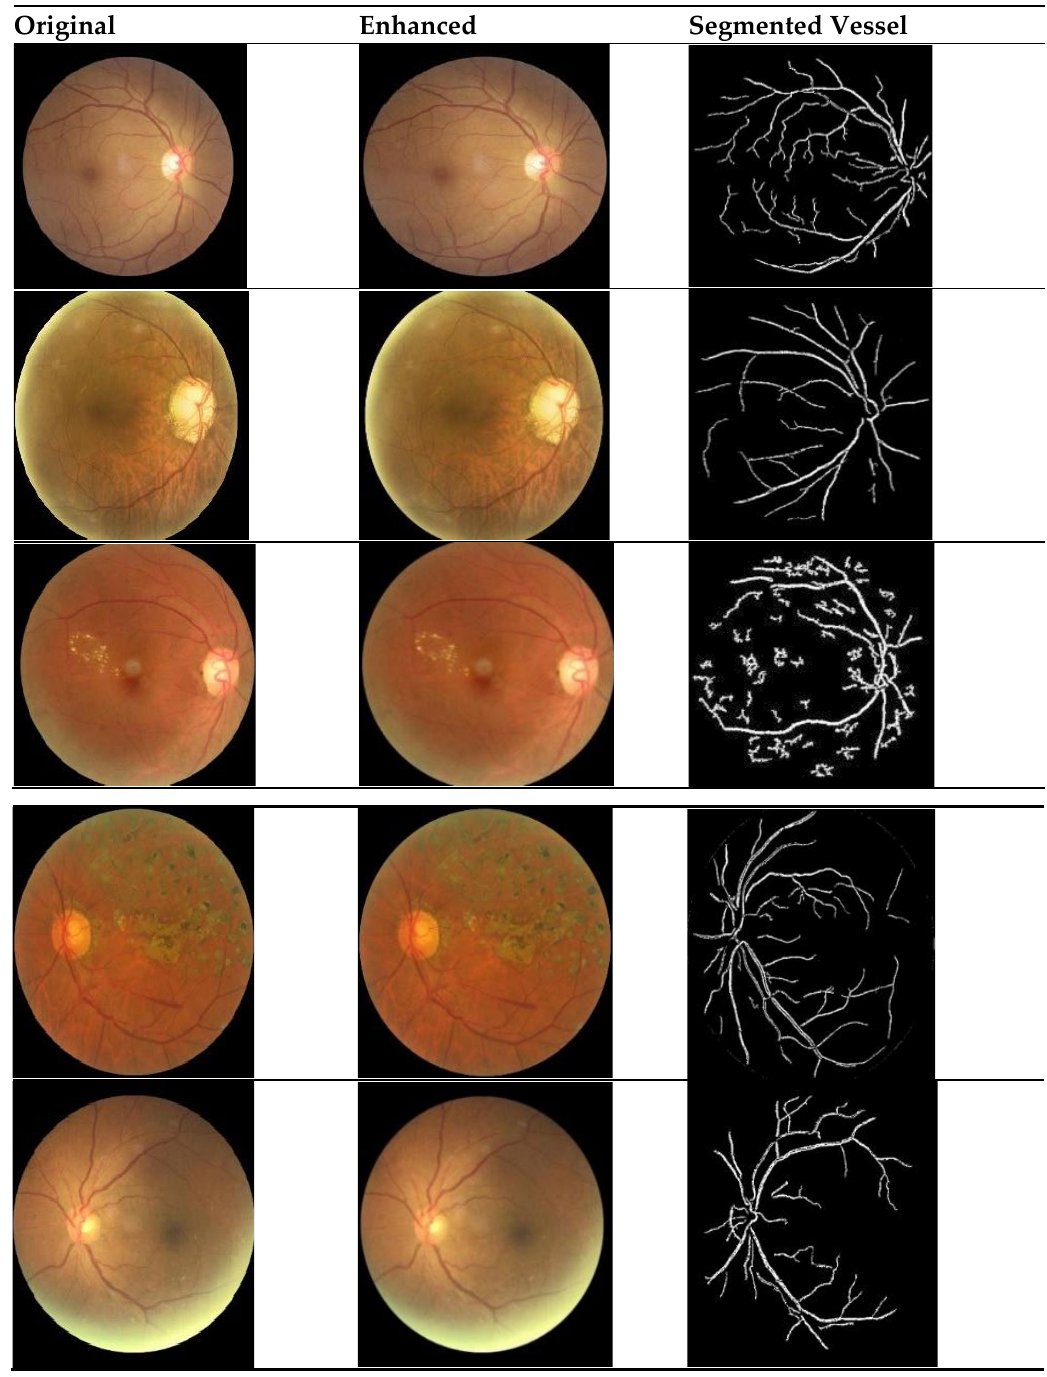
Figure 8. Segmented images (original, enhanced, segmented image).